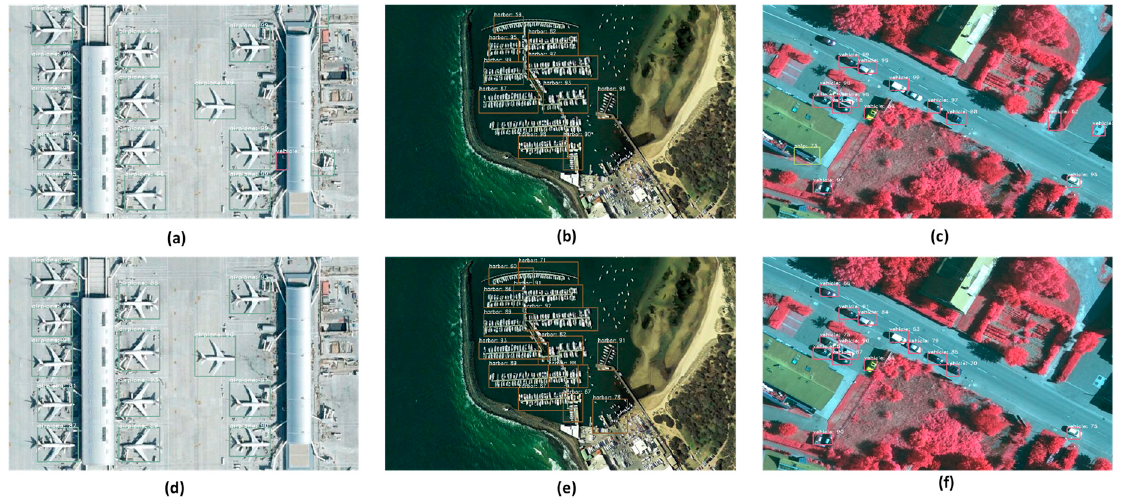
Figure 9. Detection results of Faster RCNN and proposed method. (a) – (c) denotes the results of Faster RCNN with ResNet50; (d) – (f) denotes the results of proposed method; (a – f) show the detection results of airplanes, harbors, vehicles respectively.